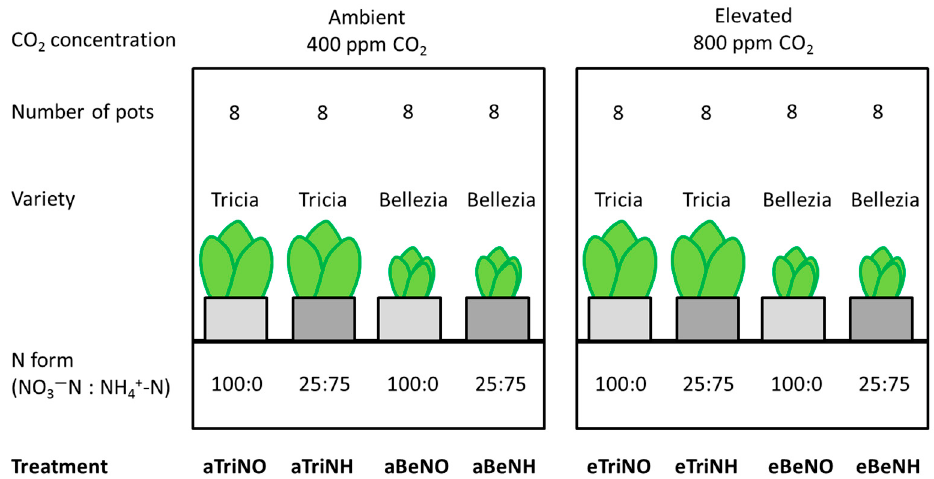
Figure 1. Design of one experimental set. One rectangle represents one climatic chamber. This set-up was repeated three times